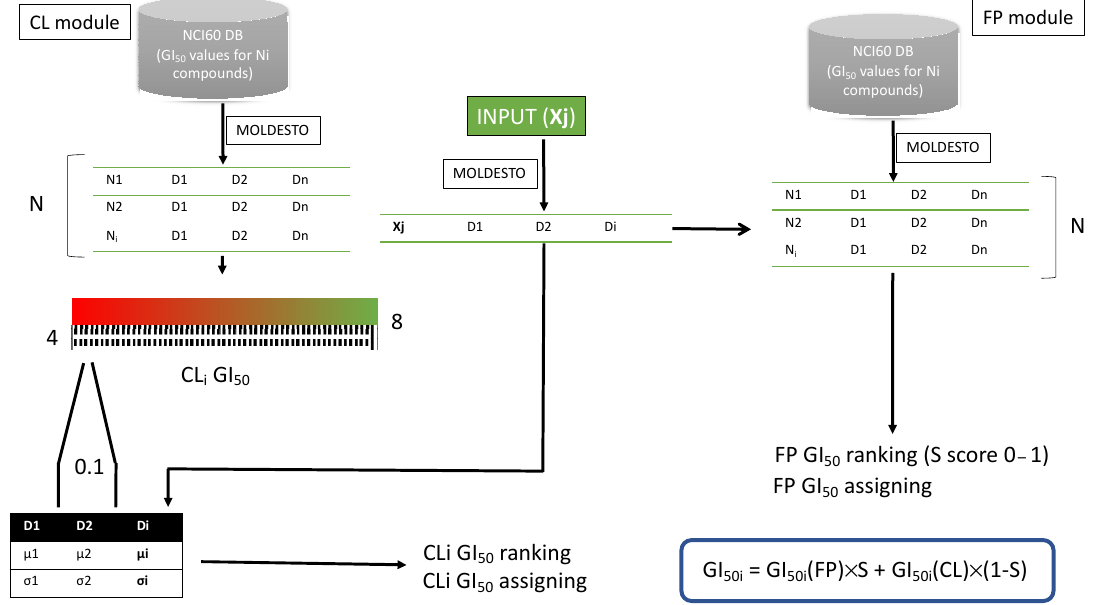
Figure 1. Flowchart of the antiproliferative predictor protocol: GI 50i is the GI 50 value for cell line, S is the fingerprint score, GI 50i (FP) is the GI 50 value predicted by the FP module, and GI 50i (CL) is the GI 50 value assigned by the CL module.